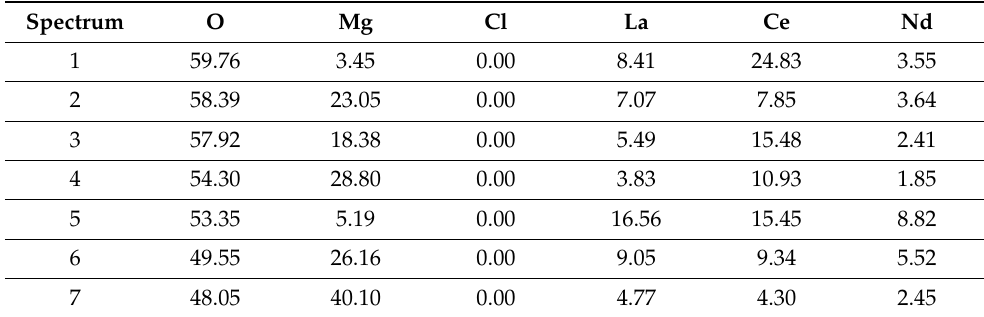
Table 3. Data on the elemental analysis of the REM oxides pellet sampled from different points illustrated in Figure 12, atomic